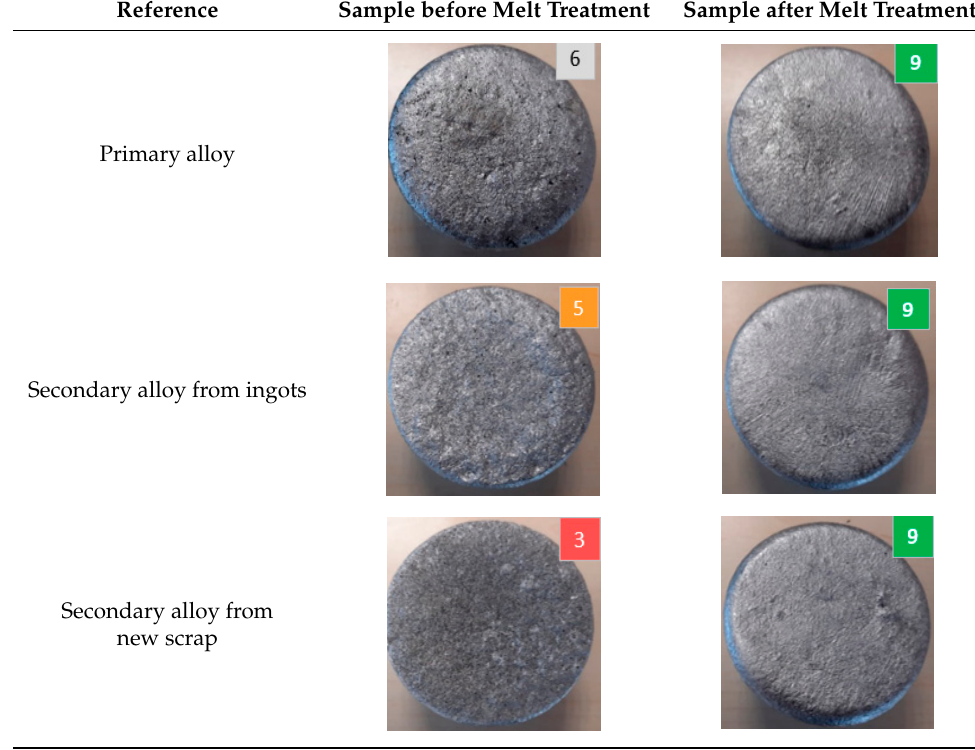
Table 3. The macroinclusion levels of the melt were classified following the chart shown in Figure 3, with 1 being the worst inclusion level and 10 being a perfect situation.